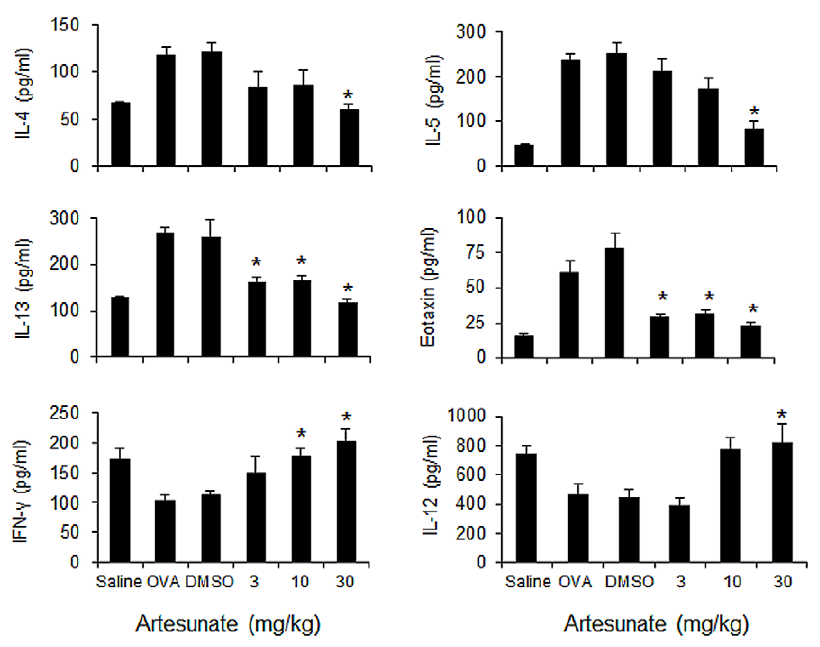
Figure 2. Effects of artesunate on OVA-induced BAL fluid cytokine and chemokine levels. BAL fluids were collected 24 hours after the last OVA aerosol challenge. Levels of IL-4, IL-5, IL-12, IL-13, eotaxin and IFN- c were analyzed using ELISA (n=6–9 mice). Lower limits of detection were as